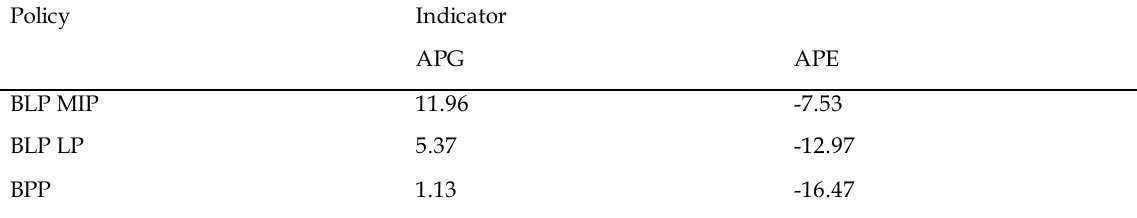
Table 2. Average percentage gain and average percentage error of proposed policies Policy Indicator APG APE BLP MIP